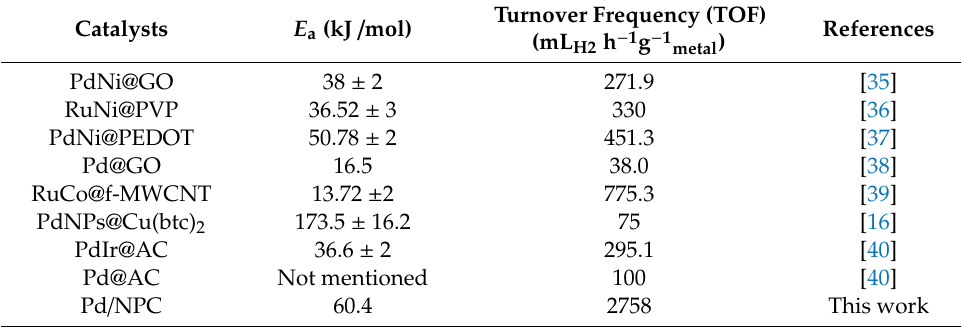
Table 1. Comparison results of Pd catalysts for DMAB hydrolysis.